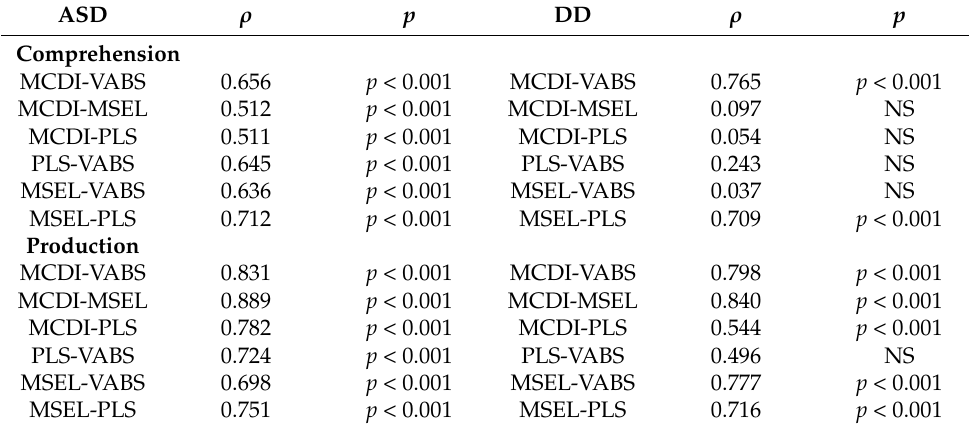
Table 1. Spearman correlations between measures of